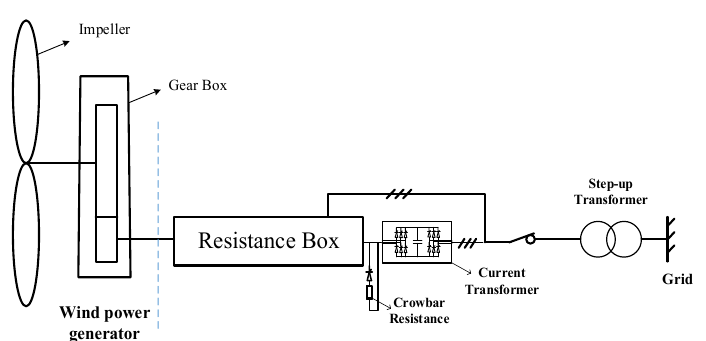
Figure 3. Schematic of a constant power factor control mode wind turbine.